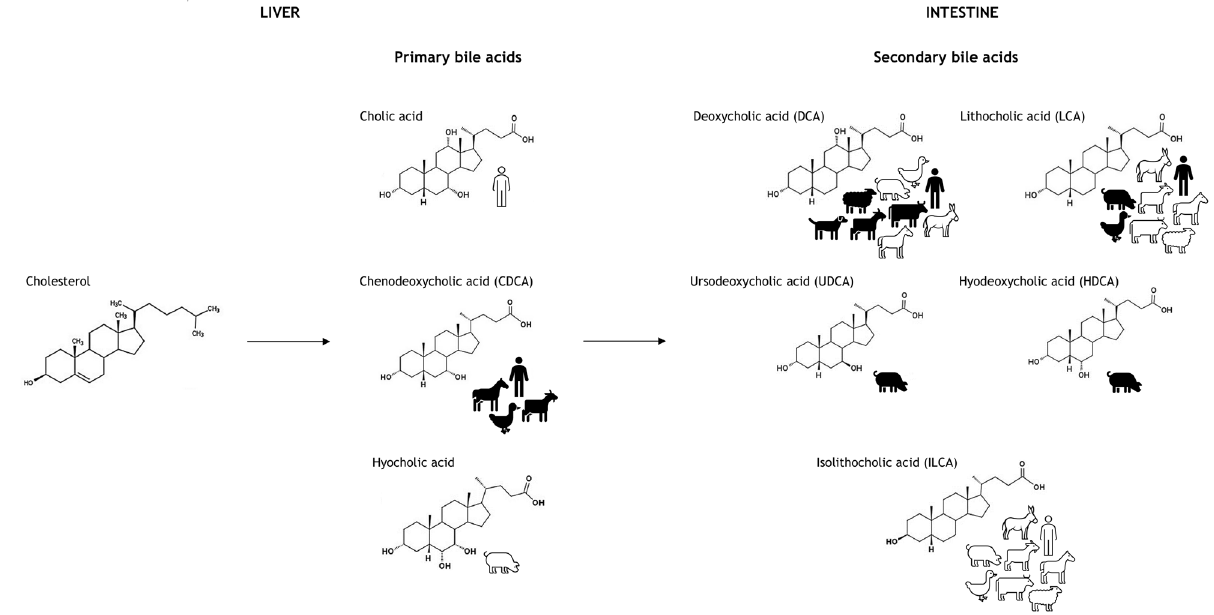
Figure 2. Primary and secondary bile acids: prevalent compounds in black pictures (modified from Prost et